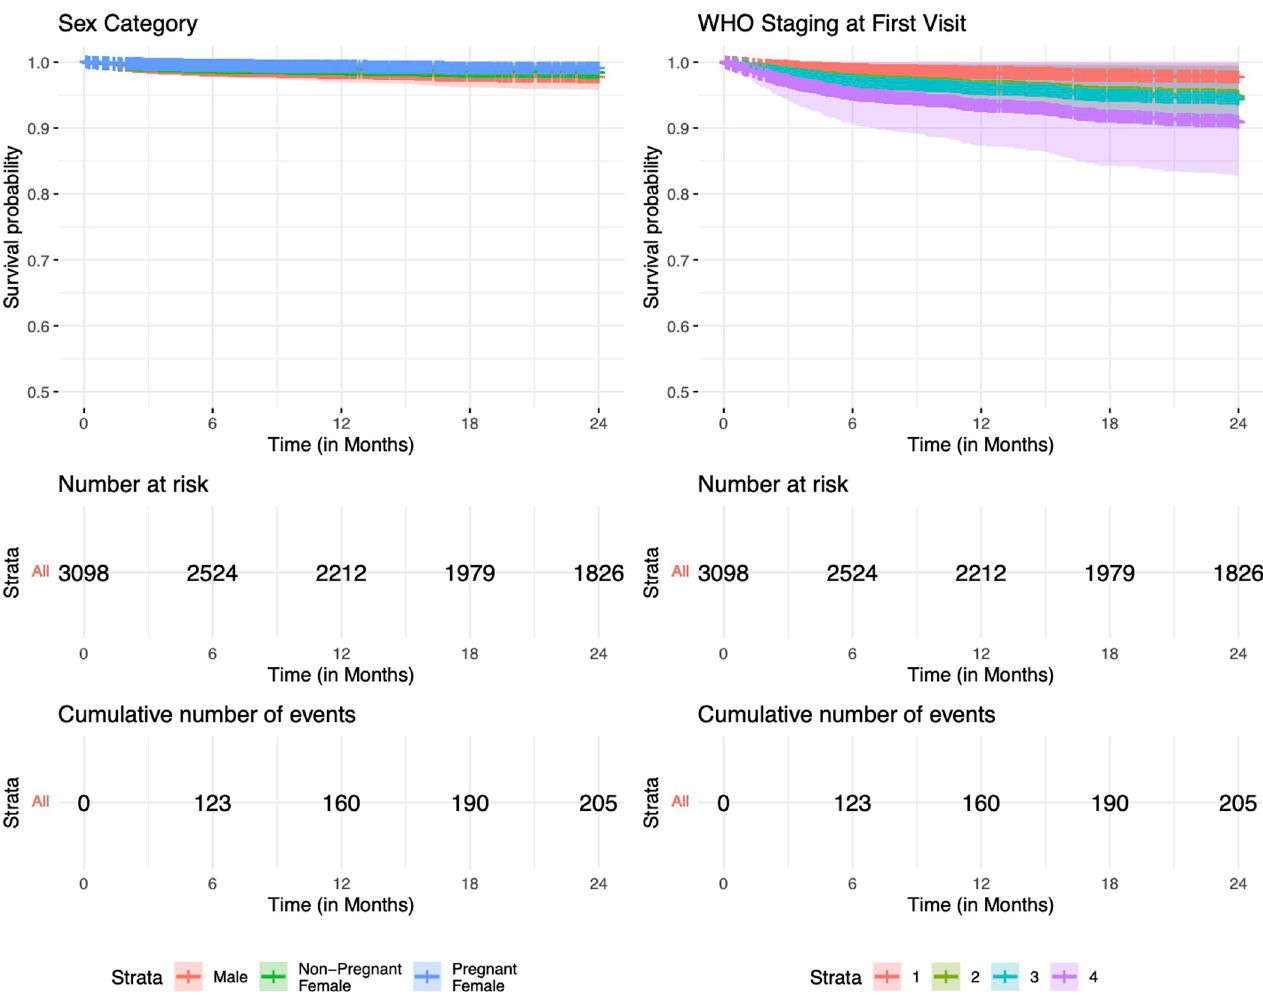
Fig 5. Kaplan-Meier survivor estimate per age category and WHO clinical stage classification at registration in care and treatment among patients followed for 24 months.